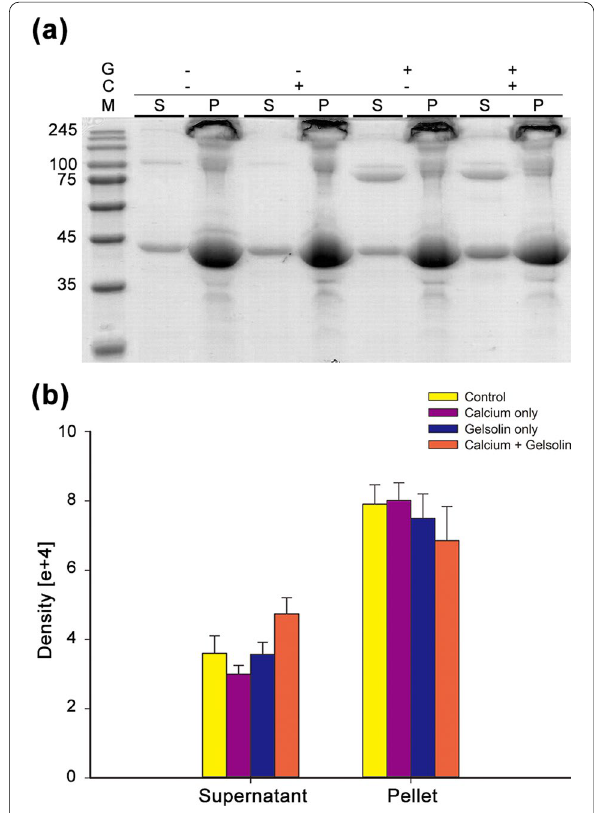
Fig. 3 Gelsolin activity in scallop muscle. Denote changes in the migration pattern of actin band from homogenized scallop muscle to confirm actin recover activity. SDS‑PAGE result of homogenized scallop muscle with different conditions; control, with calcium, gelsolin and both (See tendency of actin band in each column) ( a ) and statistically analyzed intensity of each band ( b ). The graph represents the average intensity values of migrated bands (mean SD., n 8). In the presence of activated gelsolin (i.e., with ± = calcium ion), actin showed prominent movement from pellet to supernatant. S indicates supernatant, while p represents pellet. M, Marker; C, Calcium; G,